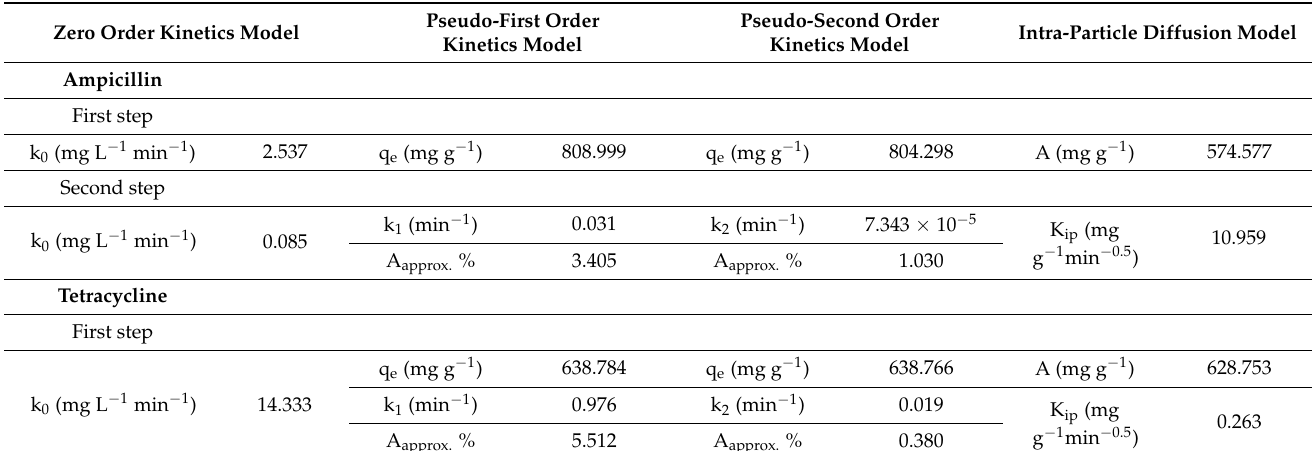
Table 1. Kinetic model parameters for the ampicillin and tetracycline sorption by zinc oxide nanoparticles. Pseudo-First Order Zero Order Kinetics Model Kinetics